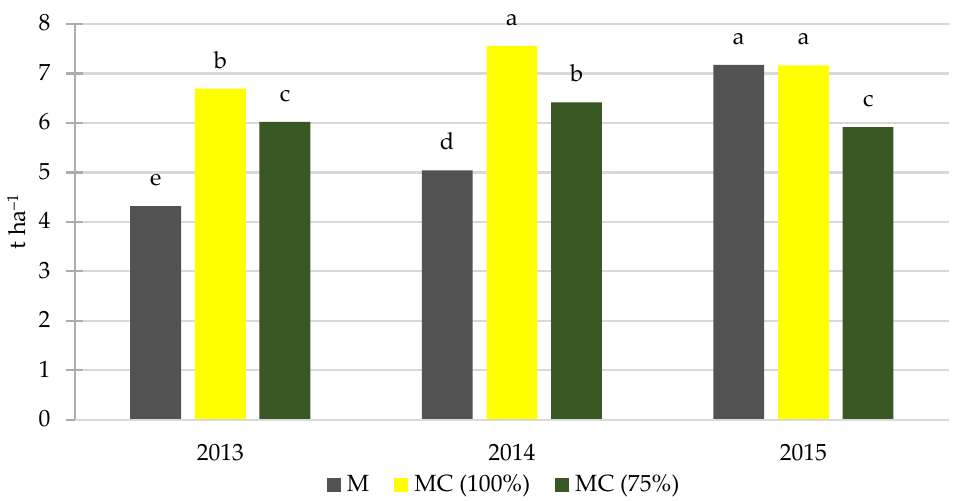
Figure 2. Interaction of the weed control methods and research years in determining spelt wheat grain yield. M—mechanical; MC (100%)—mechanical and chemical (dose of herbicides 100%); MC (75%)—mechanical and chemical (dose of herbicides 75%). Different letters denote significant differences ( p ≤ 0.05). The same letter represents not significantly different values ( p ≤ 0.05).